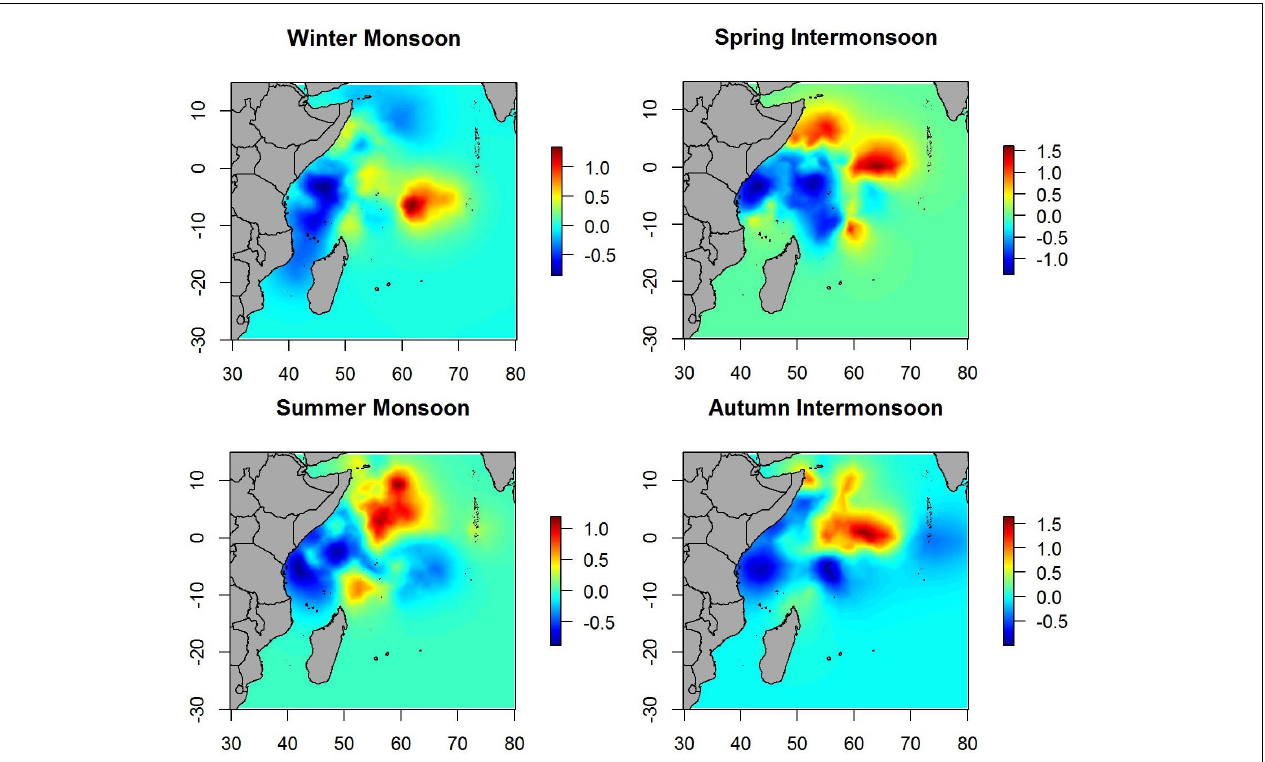
FIGURE 7 | Maps of the posterior mean of the spatial effect of non-tuna in different seasons.